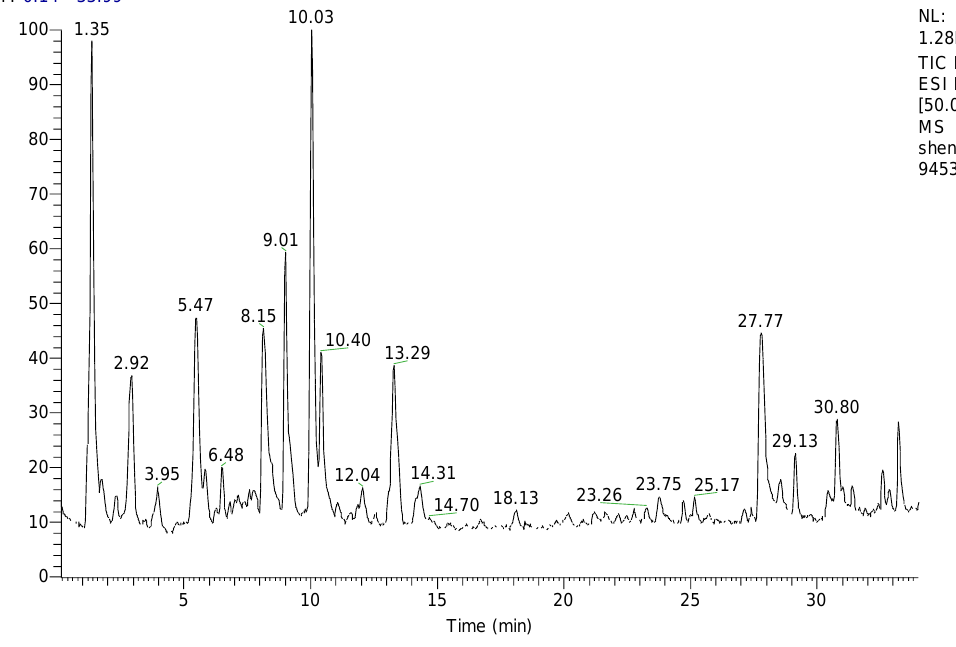
Figure 1. The total ion chromatographic (TIC) of Semen Cuscutae